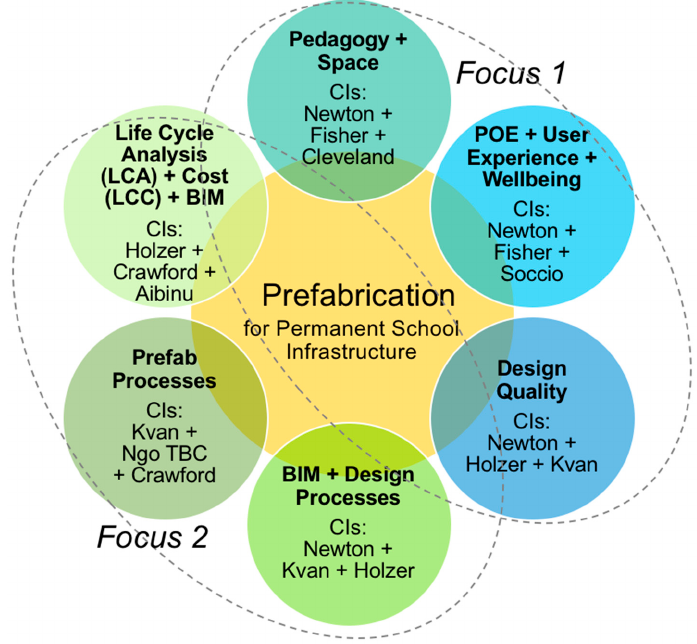
Figure 1. Taking a multi-disciplinary perspective to prefabricated schools. Image: Authors.